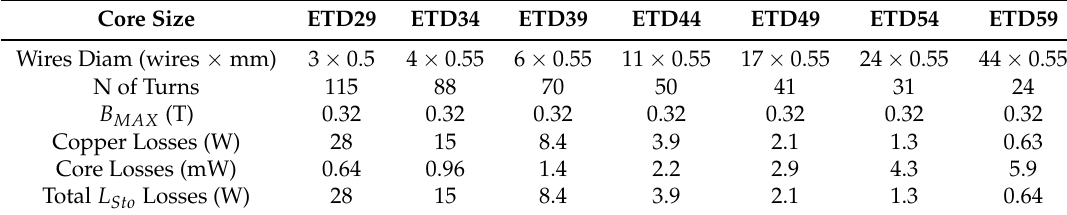
Table 7. Main Inductor Design Outputs for D = 0.025 ( L Sto = 190 µ